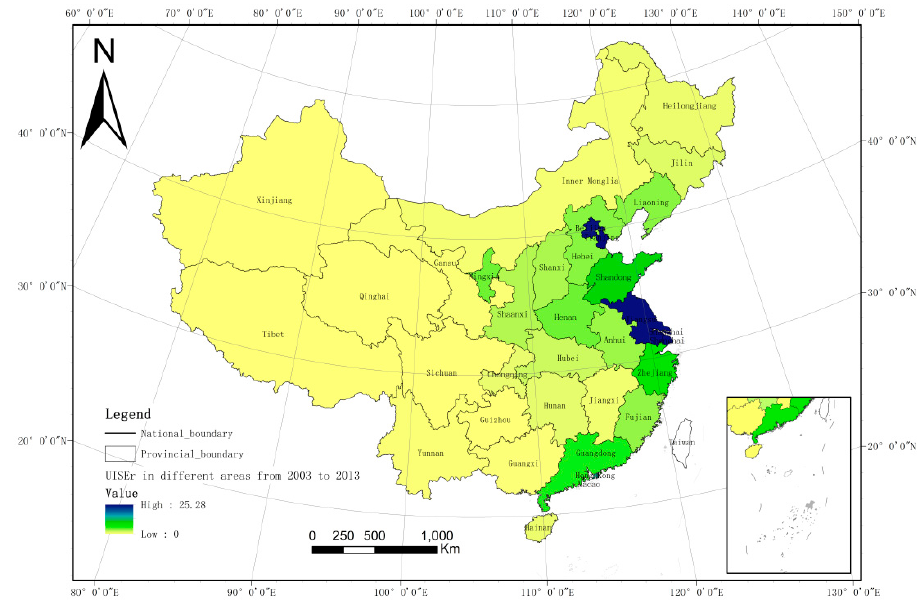
Figure 8. Provincial city impervious area growth rate change chart from 2003 to 2013. 433